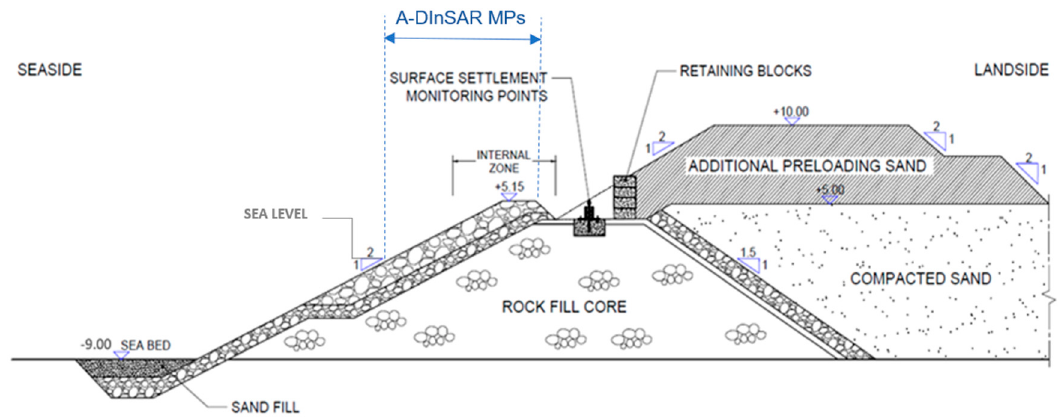
Figure 19 . Typical cross-section in the outer revetment at the location of land survey point during preloading with fill embankment.